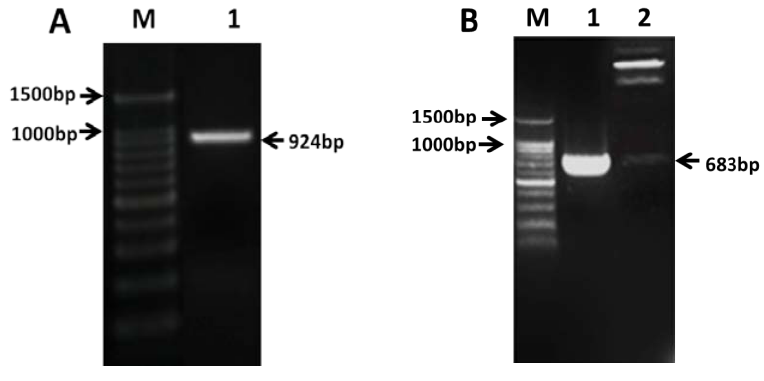
Figure 1. ( A ) Cloning of PAP3 in sterile line. M : 100 bp DNA ladder; 1 : band of